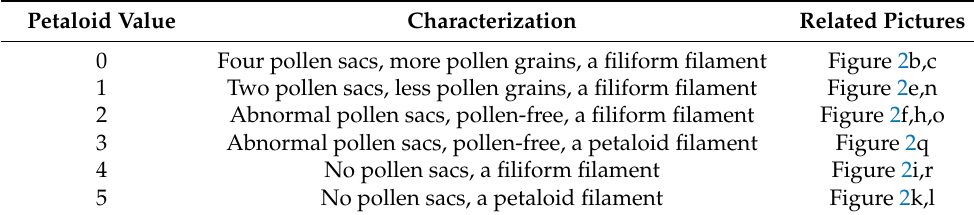
Table 2. Definition of the petaloid value of stamen at the blooming stage. Petaloid